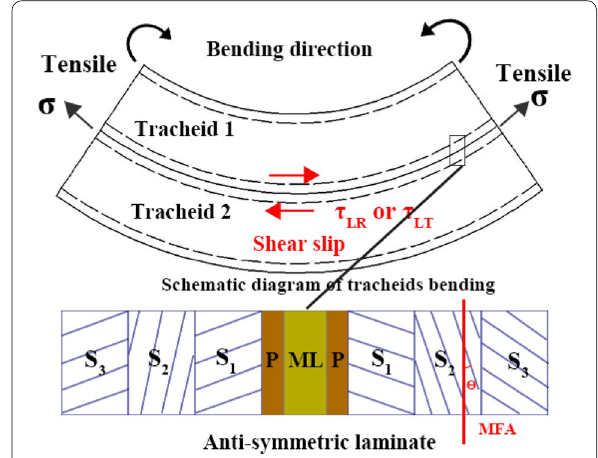
Fig. 9 Stress analysis of the cell wall under radial or tangential loading